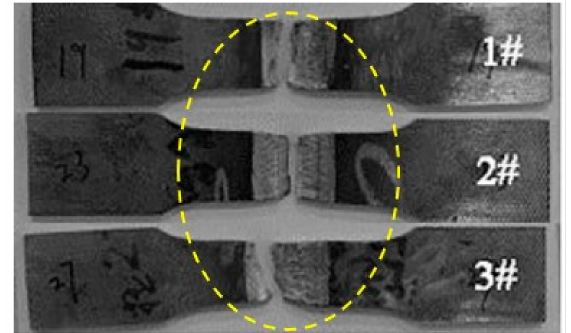
Figure 6. Fracture position of flat tensile specimens of DSS 2205 solid wire MIG welding joints prepared in different shielding gases. 1#-Ar; 2#-98%Ar + 2%O 2 ; 3#-98%Ar + 2%N 2